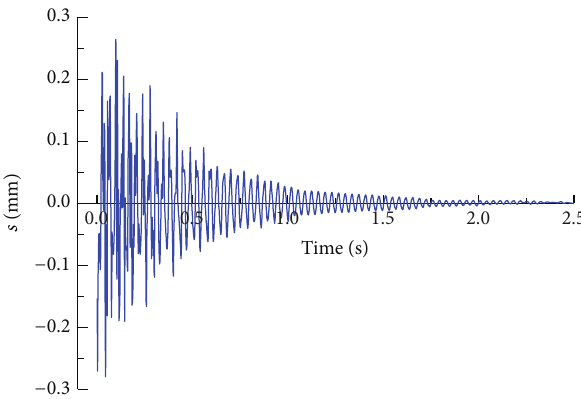
Figure12:Thedynamicresponsetimehistorycurvesofthebuilding